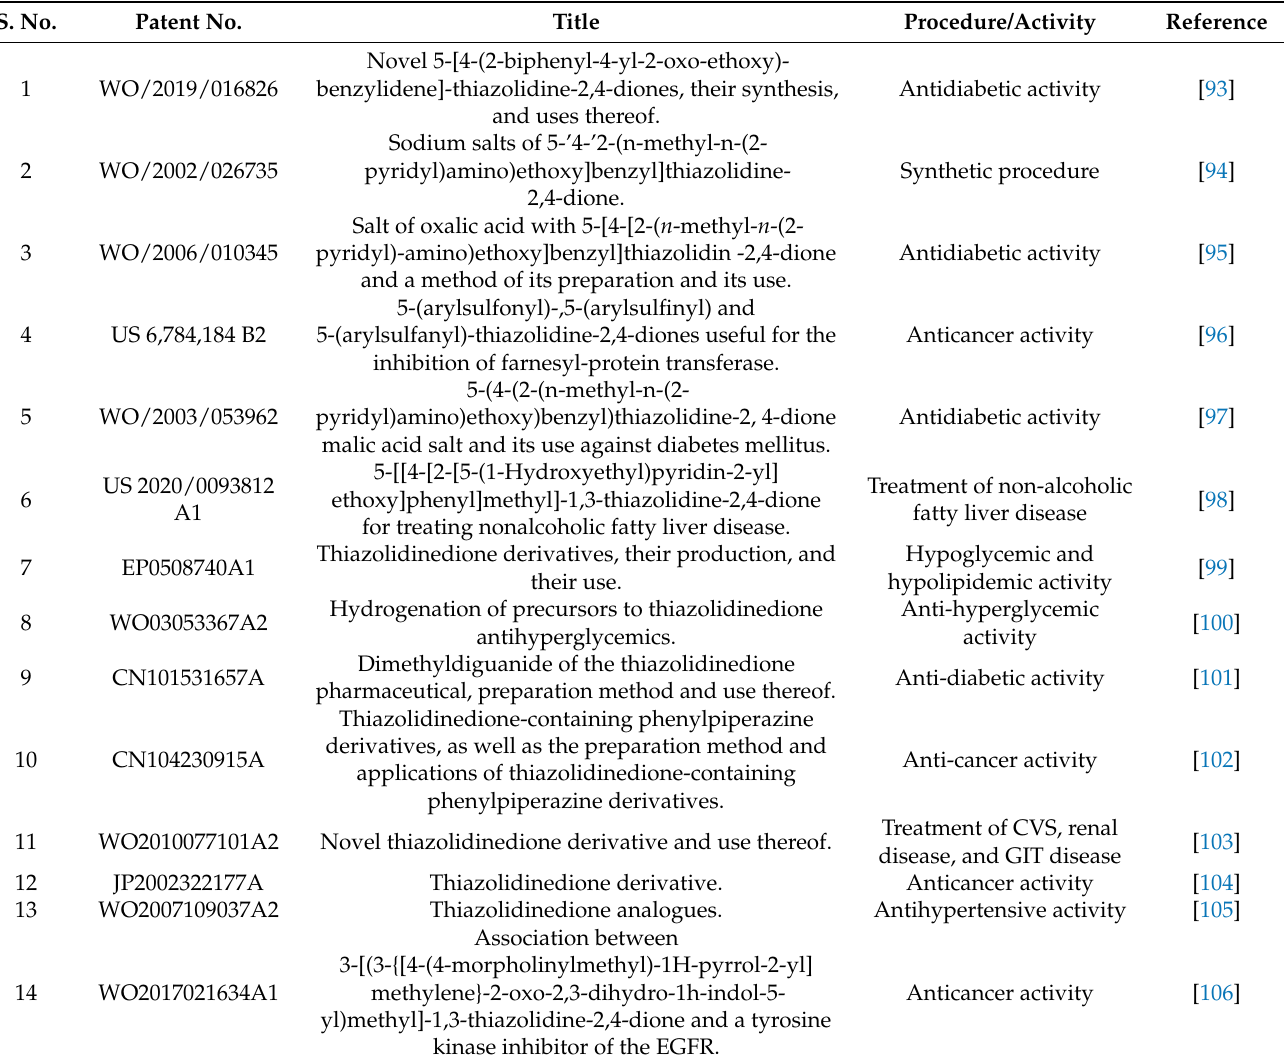
Table 65. Patent grant information of the thiazolidinedione